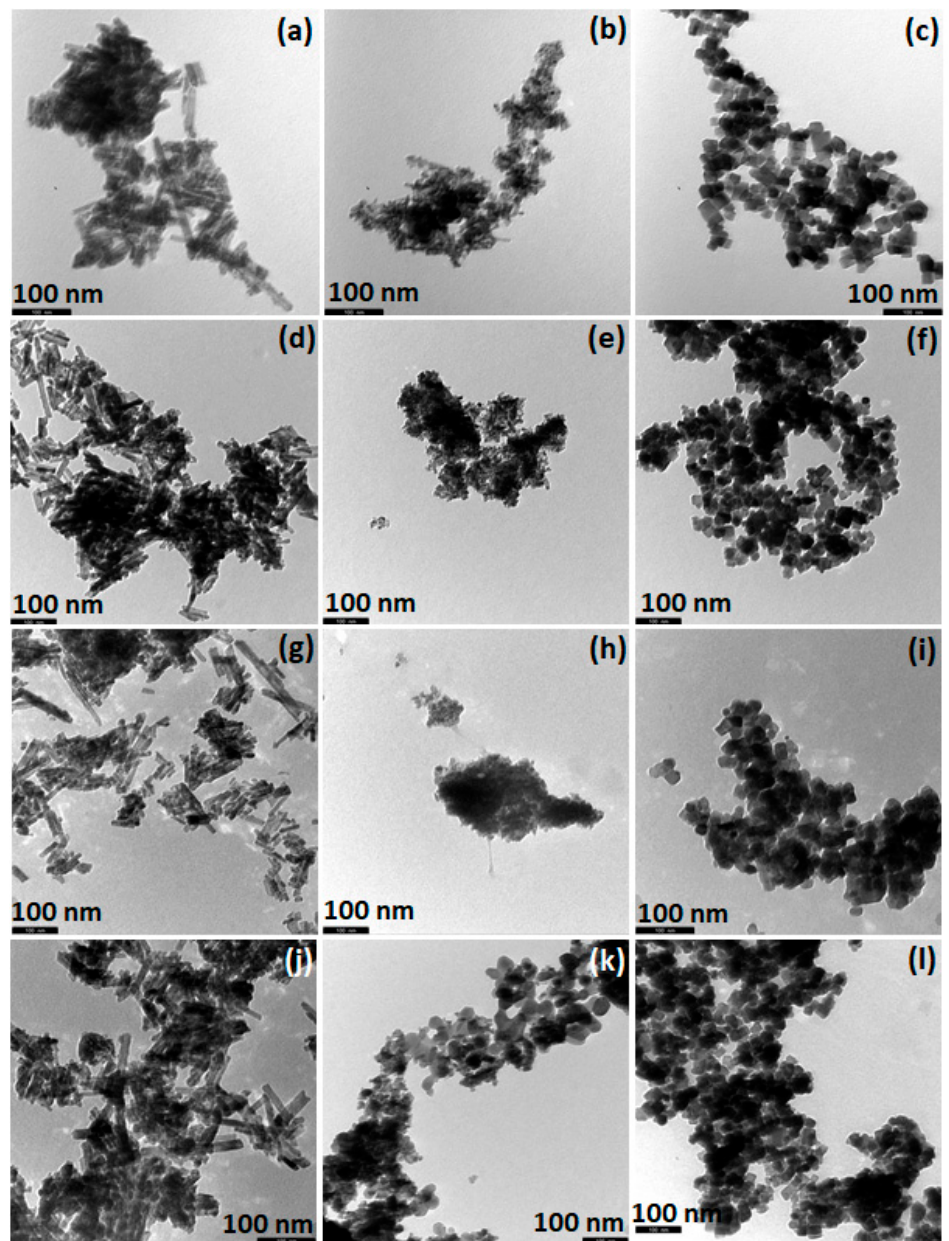
Figure 7. Indicative TEM images of TM/ceria (TM: Cu, Co, Fe, and Ni) nanoparticles: ( a – c ) Cu/CeO 2 , ( d – f ) Co/CeO 2 , ( g – i ) Fe/CeO 2 , and ( j – l ) Ni/CeO 2 samples of ( a , d , g , j ) rod-like, ( b , e , h , k ) polyhedral and ( c , f , i , l ) cubic morphology.